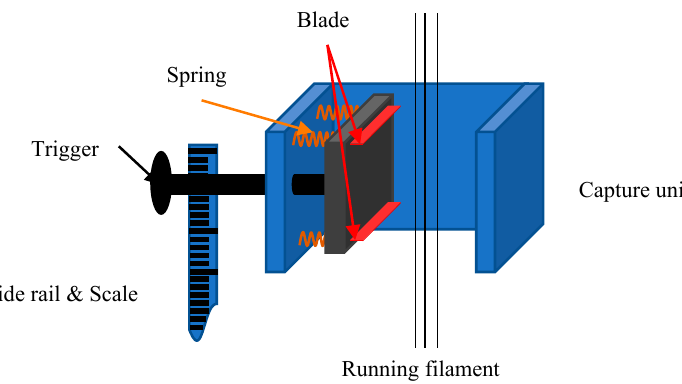
Figure 1. Schematic diagram of the capture device made by our group.